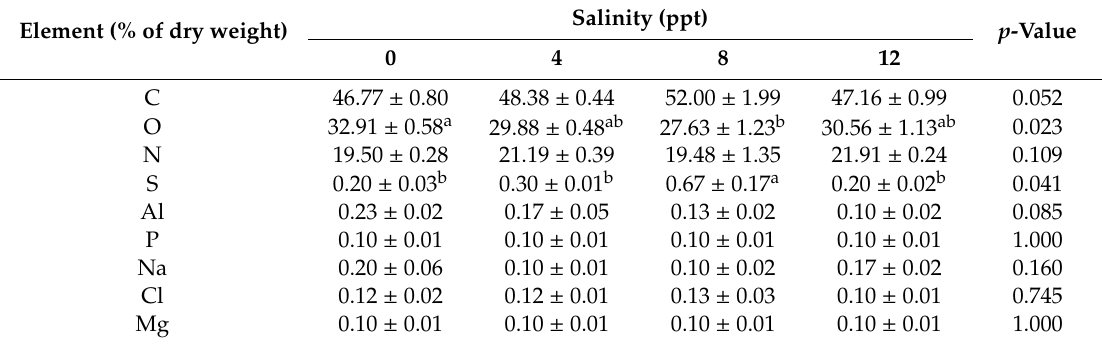
Table 3. Carapace elemental profiles of northern river terrapin reared in various salinities. The sampling was done at the end of the 8-week experiment.